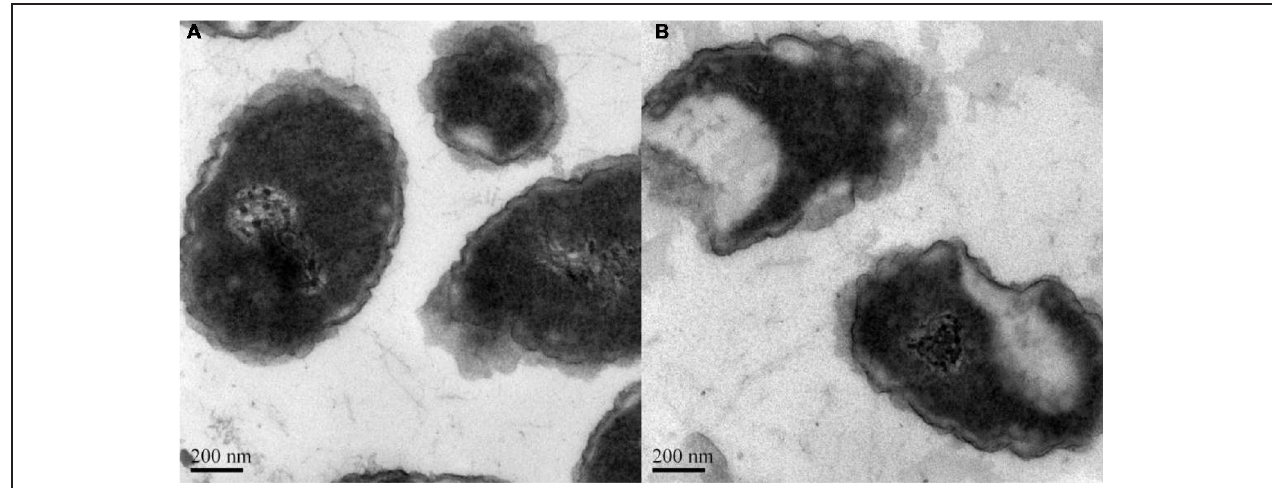
FIGURE 7 | Bactericidal effect of Ts-LPs-LEV. Electron micrographs of K. pneumoniae ATCC 700603 incubated for 1 h after receiving (A) saline or (B) Ts-LPs-LEV. The length of the scale bar in the TEM image is 200